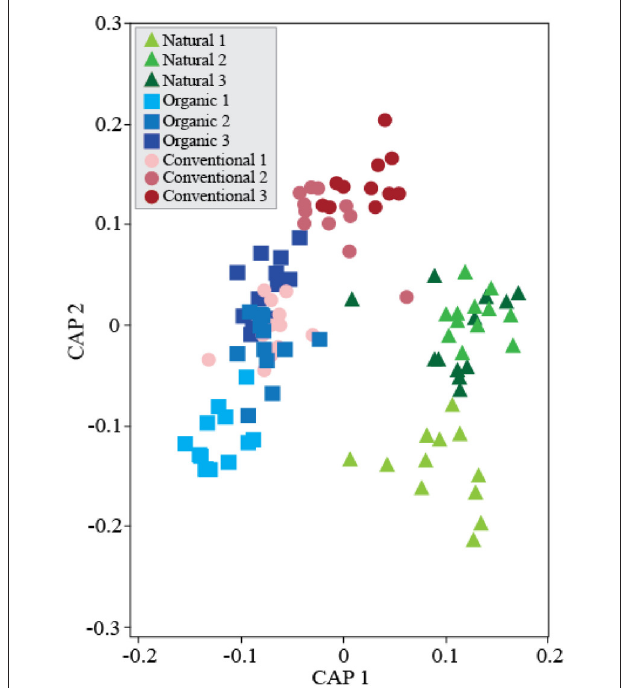
FIGURE 3 | Temporal shifts of soil bacterial communities across soil management regimes. Canonical Analyses of Principal Coordinates based on constrained ordination by soil management * time . First axis δ 2 = 0.91 and second axis δ 2 = 0.89. TraceQ_m’HQ_m statistic: 4.28*** (*** P < 0.001). Soil samples were collected every 30 days for community composition assessments. This analysis did not include treatment effects in the constrained